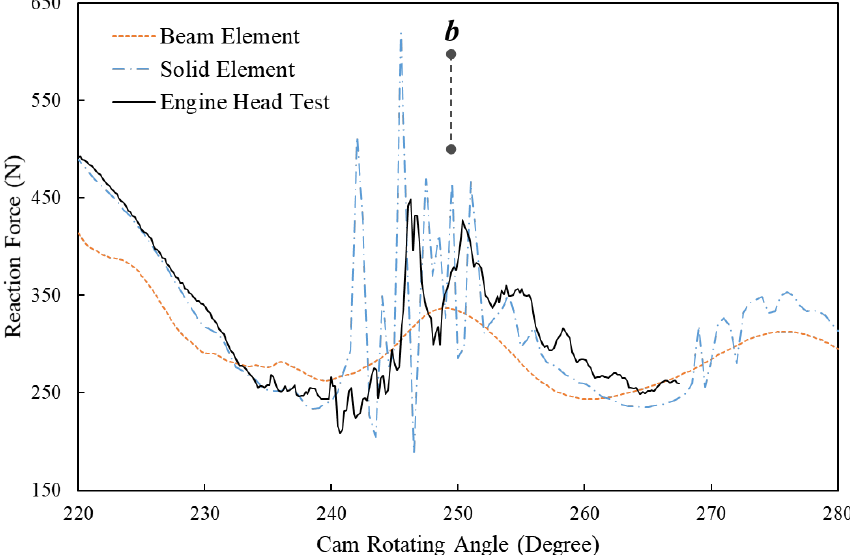
Figure 6. Comparison between the spring reaction forces at 5600 RPM engine speeds of the dynamic FE results using beam elements and solid elements and the results of the engine head test (zoom-in area between the 220-degree and 280-degree cam angles).